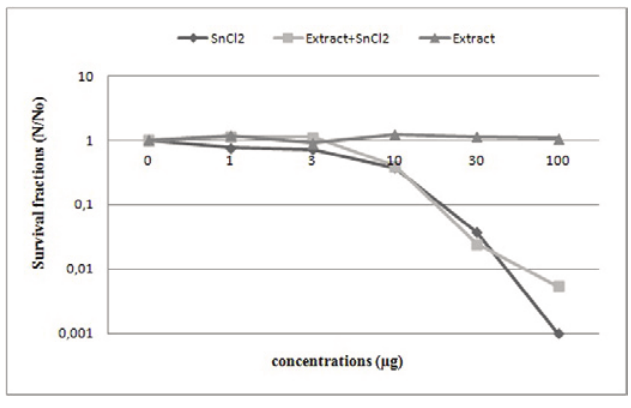
FIGURE 2 - Survival fractions of bacteria in the groups of i. SnCl Extract + SnCl , iii. 2